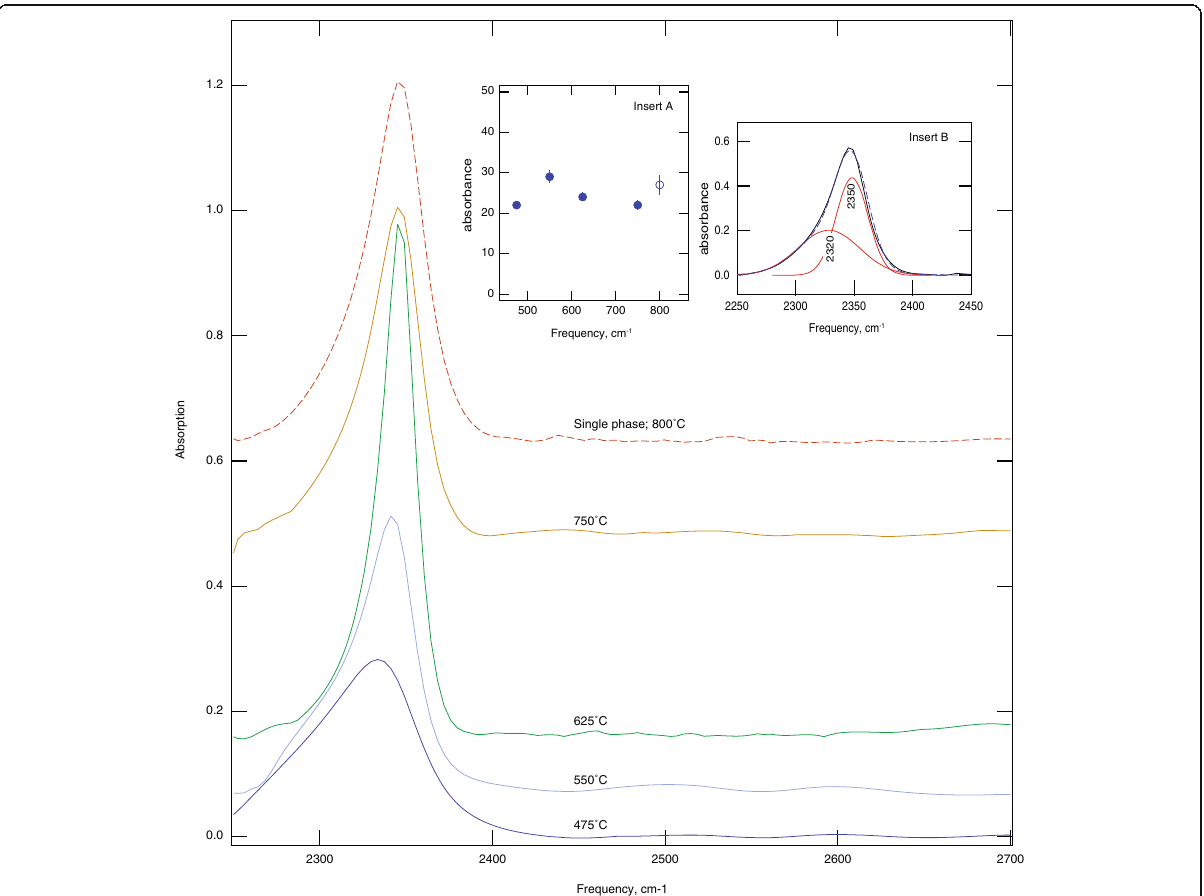
Fig. 4 Infrared absorption spectra of fluids in the spectral region of C – O stretching in CO 2 molecules as a function of temperature and pressure (see Table 1 for pressures). The spectra are offset for clarity. The vertical line is the scale bar for the Absorption intensity of the spectra. Inserts A and B show the integrated intensities of the absorption and an example of 2-line curve-fitted infrared spectrum by using Gaussian line shape. The spectrum shown was recorded while the sample was at 750 °C. Dashed line is from 800 °C where a single fluid phase only